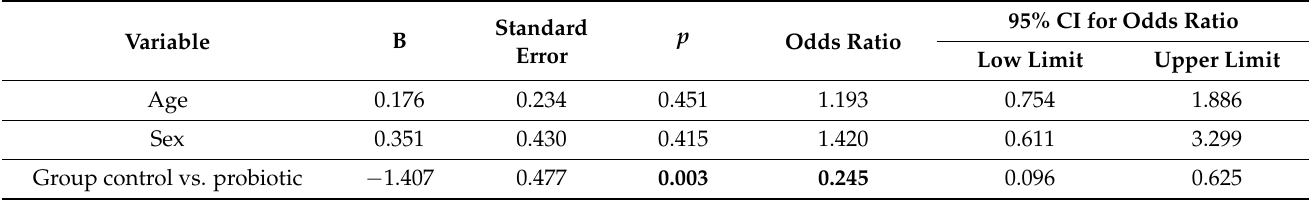
Table 4. Multivariate analysis of ∆ ICDAS 3–6 > 0; 12 months—baseline, n (%).